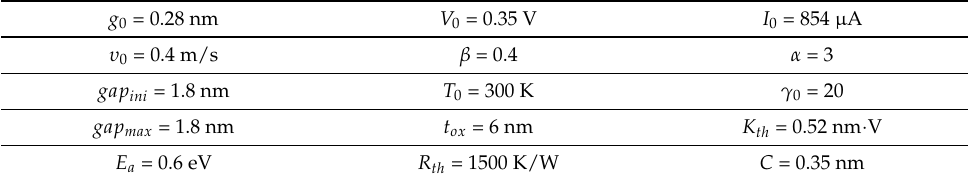
Figure 3. Comparison between the median values (doted line) of the experimental cycles (grey line) and the simulated results (straight line) concerning the Stanford-PKU model extended with multilevel capability ( a – d ), the UGR-VCMCF model ( e – h ) and the UGR-VCMTCF model ( i – l ) for the LRS1 (red), LRS2 (green) and LRS3 (blue). Table 3. Fitting parameters for the Stanford-PKU modified model.